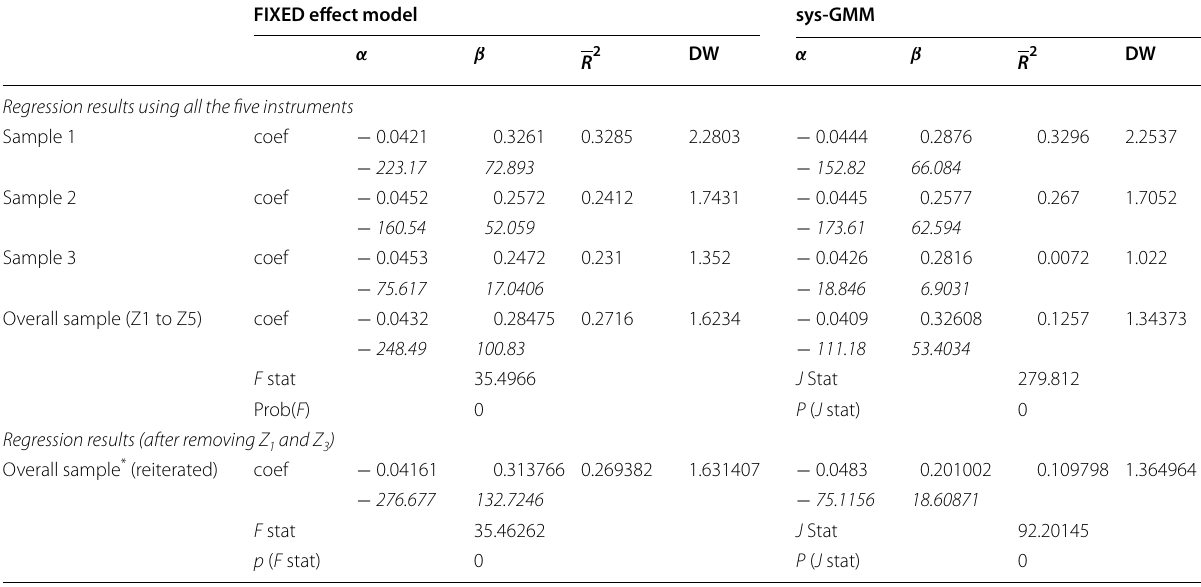
Table 5 Regression results of LSDV model and GMM with